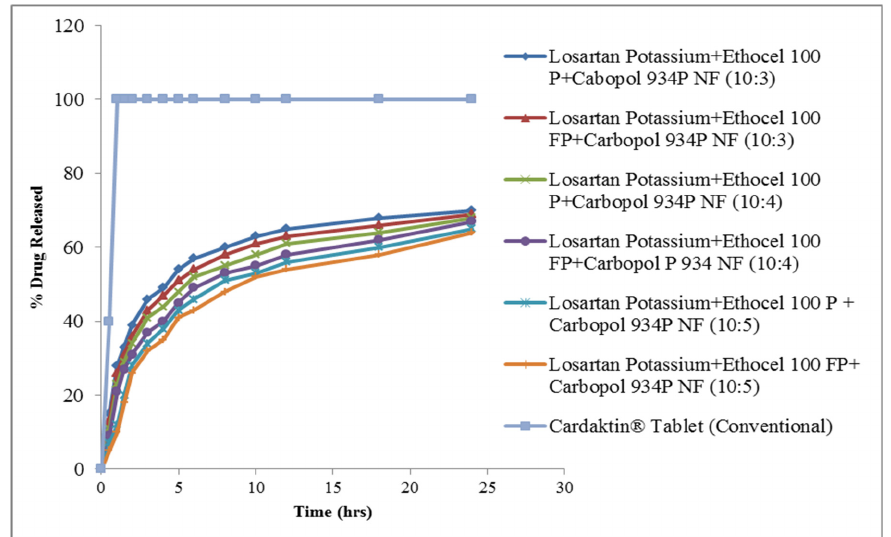
Molecules 2022 , 27 , x FOR PEER REVIEW